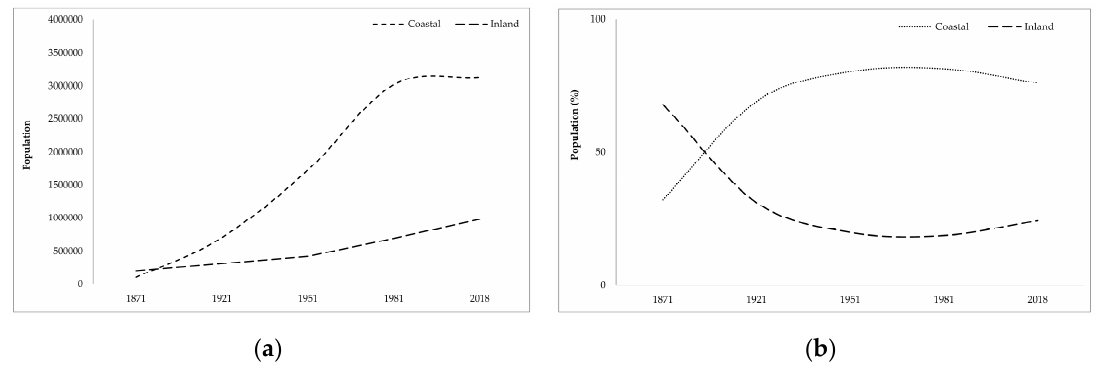
Figure 3. Total resident population ( left ) and percent share of the resident population ( right ) in the total population by district in Rome’s metropolitan area,